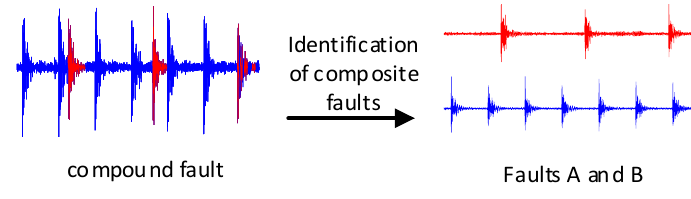
Figure 3. Capsule network identifies overlapping digits.